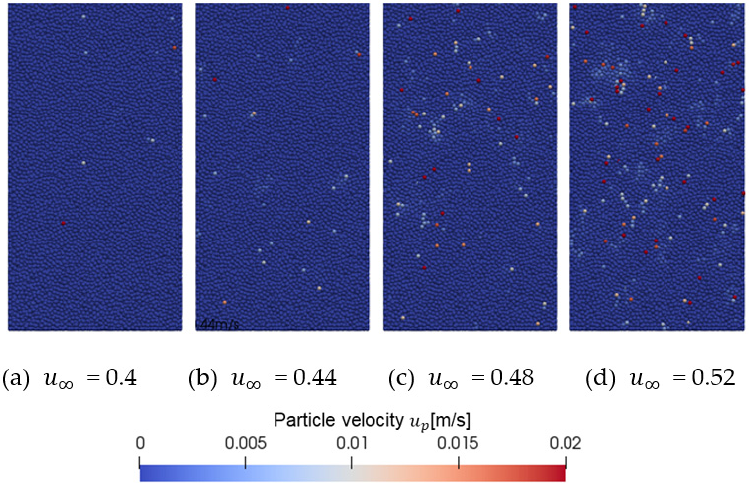
𝑑𝑧 ) at the central location in the x/D = 2.125.